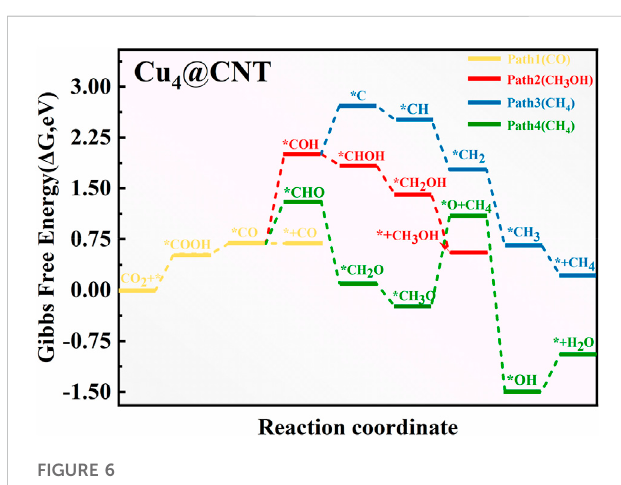
ree energy diagram of CO 2 RR on Cu 4